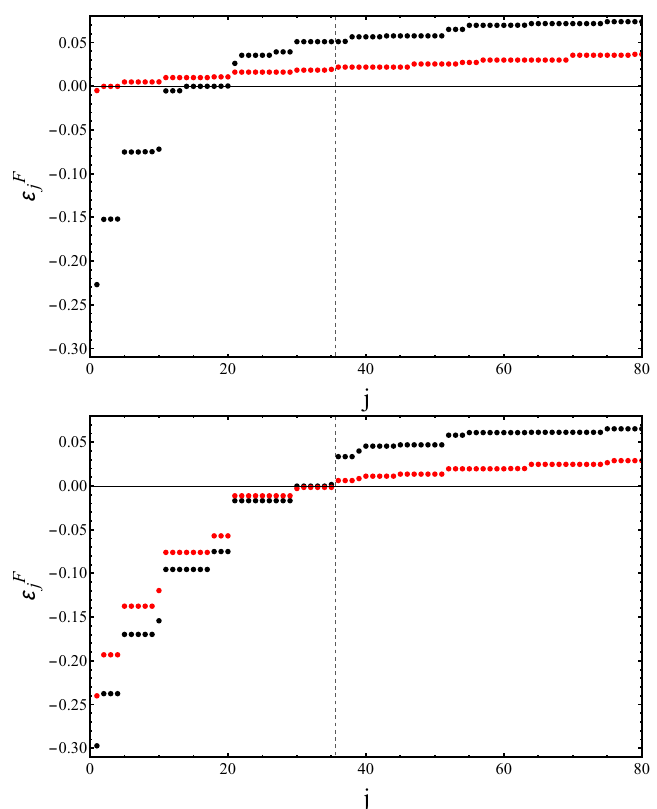
Figure 6: Single-particle energies for the system of 35 fermions immersed in a cloud of 350 bosons – in the harmonic trap (black dots), and without the trap (red dots), for the mutual scattering length equal to: a (lower panel). The solid horizontal line indicates zero energy level. The dashed vertical line is located at j = 35.5 which is exactly between 35th and 36th fermionic orbital. The total number of basis functions is